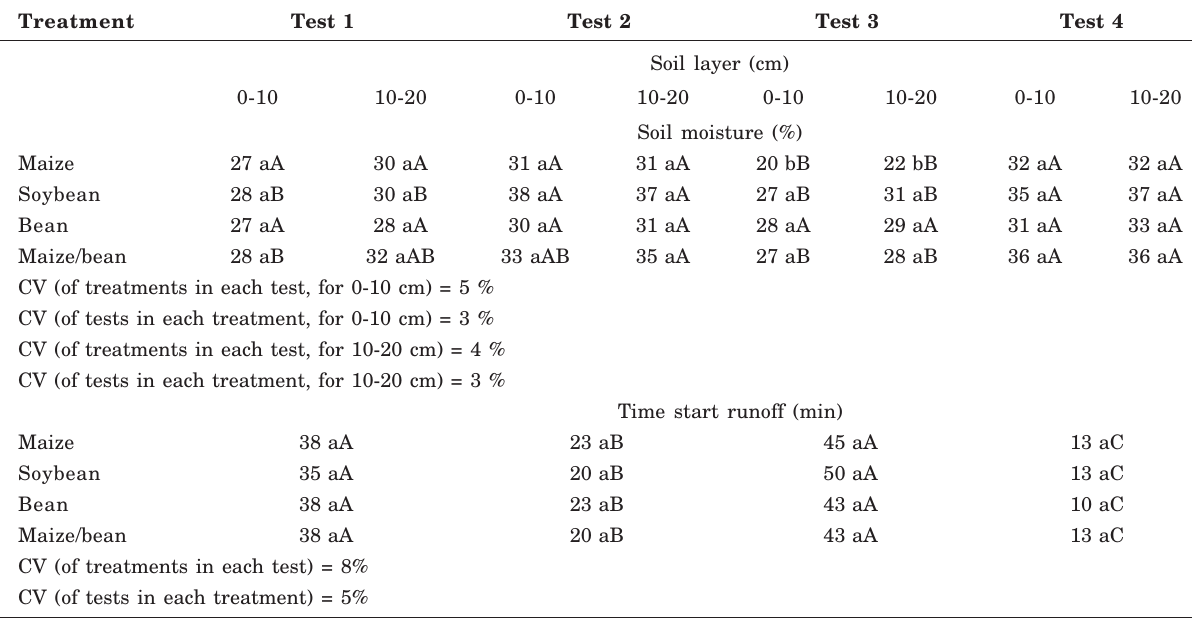
Table 2. Soil gravimetric water content before simulated rainfall application on two soil layers, and time from the start of the rainfall to start the runoff, according to the different treatments and in the four rainfall